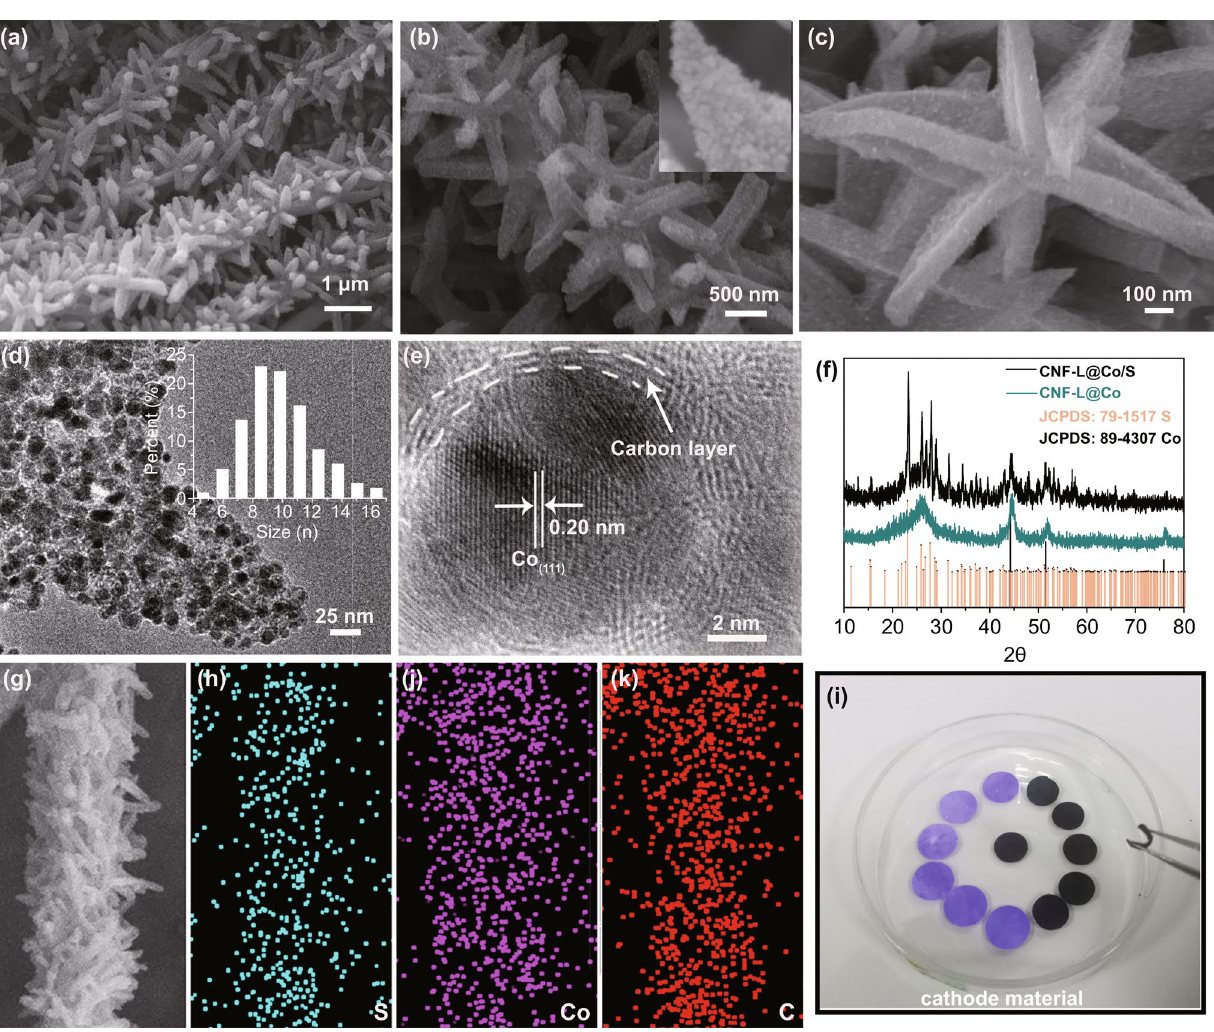
Fig. 2 Characterization composites. a–c FESEM images of CNF‑L@Co, d, e TEM images of CNF‑L@Co; f XRD pattern of CNF‑L@Co and CNF‑L@Co/S; g–k EDS elemental mappings of CNF‑L@Co/S, and i flexible films of